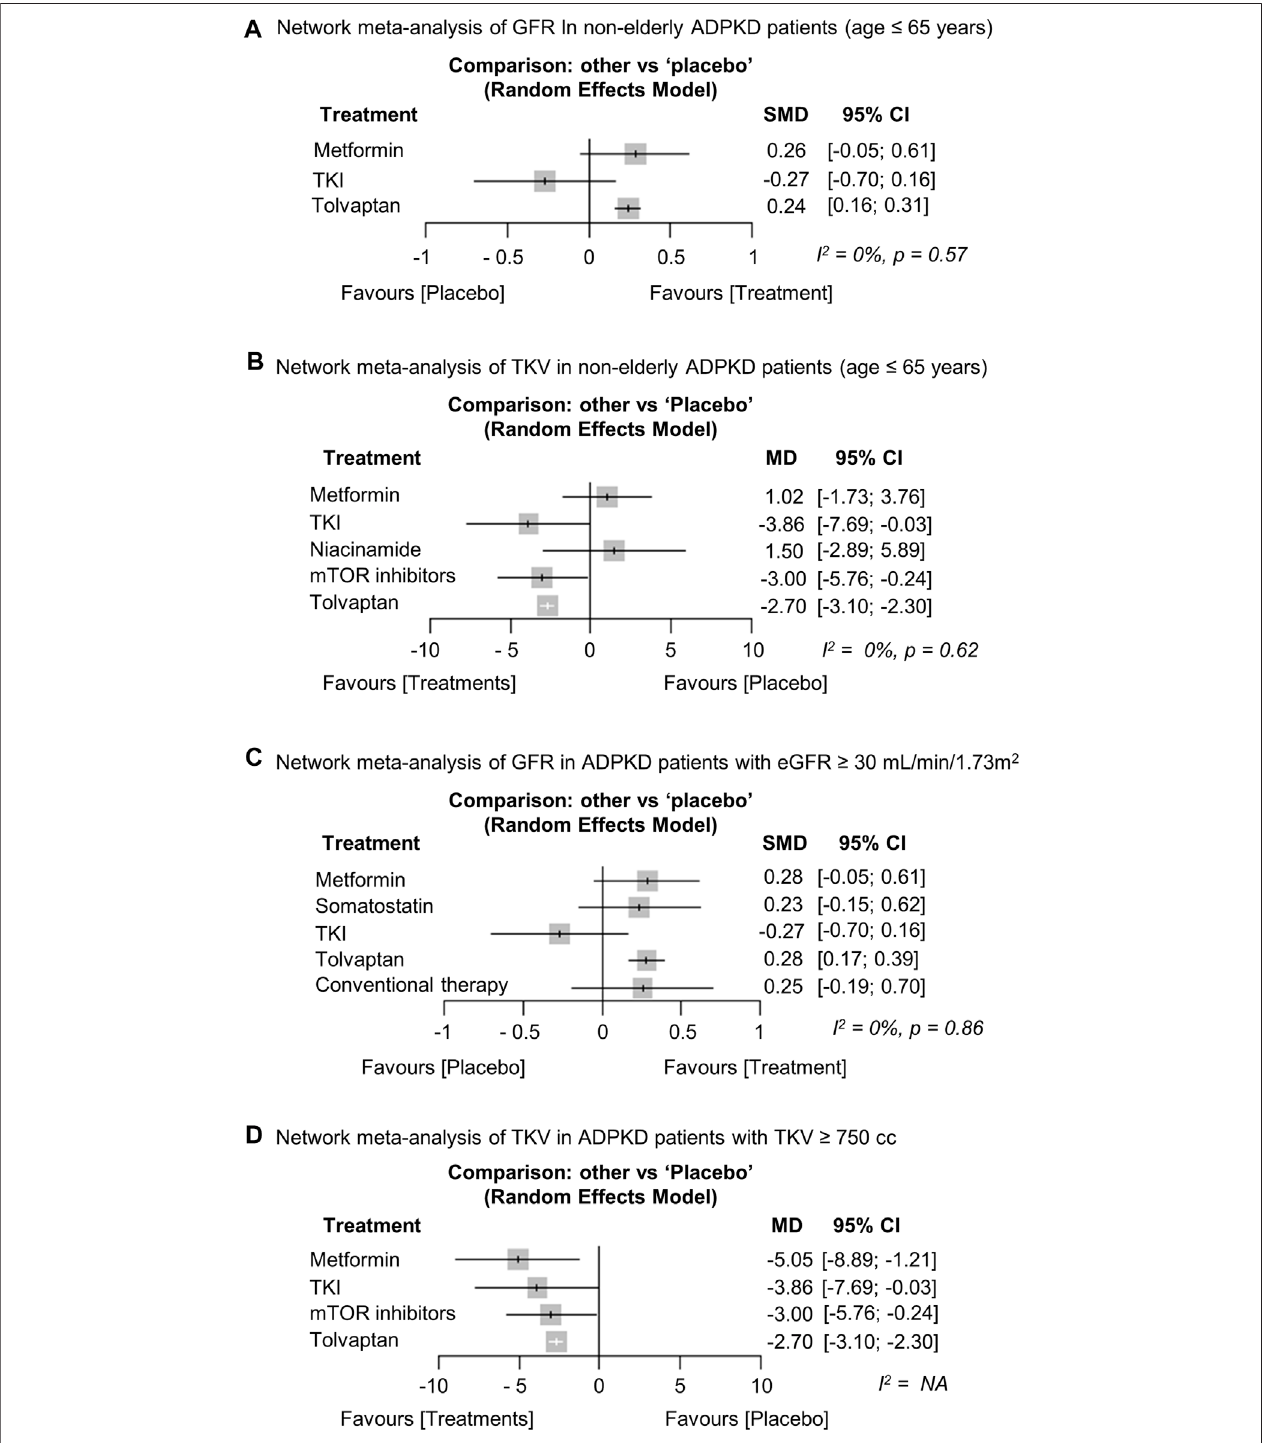
FIGURE 5 | Network meta-analysis regarding the subgroup analysis. Forest plot showing each treatment effect of (A) preserving kidney function [glomerular fi ltration rate (GFR)] and (B) inhibiting total kidney volume (TKV) growth rate compared to placebo in non-older adult ADPKD patients (age ≤ 65 years). Forest plot showing each treatment effect of (C) preserving kidney function (GFR) in ADPKD patients with baseline eGFR ≥ 30 ml/min/1.73 m 2 and (D) inhibitingTKV growth rate in ADPKDpatientswithbaselineTKV ≥ 750cc.ADPKD,autosomaldominantpolycystickidneydisease;CI,con fi denceinterval;SMD,standardmeandifference;MD, mean difference; TKI, tyrosine kinase inhibitor; eGFR, estimated